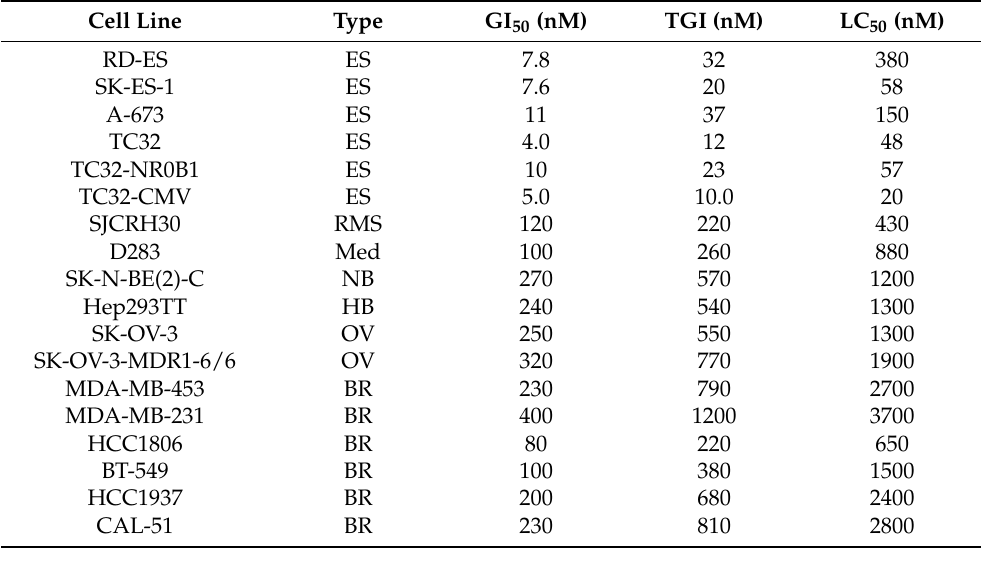
indicating an average of 30-fold selectivity for ES cells. The concentration of ATXII result- ing in 50% cell death (LC 50 ) was also significantly different ( p = 0.0001) between ES and non-ES cells (Table 1), with a mean LC 50 of 100 ± 100 nM in the six ES cell lines and 2000 ± 1000 nM in non-ES cell lines, demonstrating that ATXII has, on average, 20-fold cytotoxic selectivity for ES cells. ATXI and alteichin were not evaluated in this larger panel of cell lines because these compounds did not show any selectivity for ATXII when evaluated in the smaller panel of eight cell lines. The activity of ATXII was further assessed in A-673 ES cells by measuring its ability to inhibit colony formation. ATXII potently inhibited the